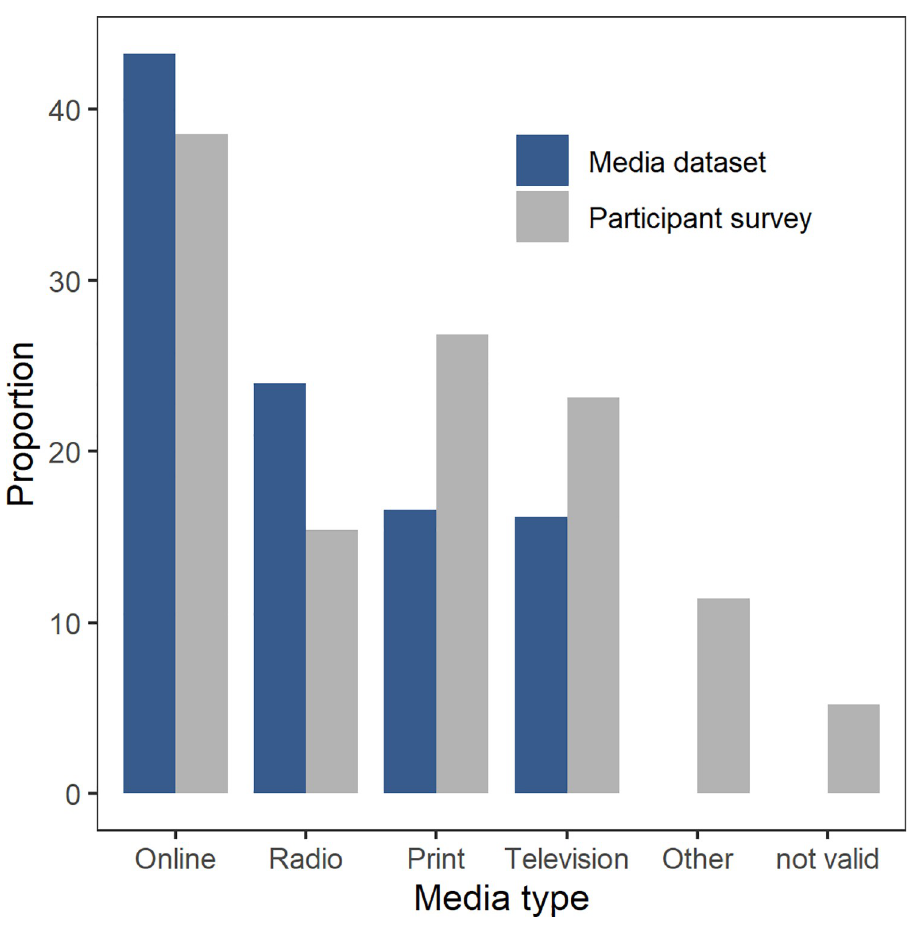
Fig 5. Comparison of the proportions of media types from the media clipping dataset and those from the participant responses. For the participant responses, the category ‘print’ also includes ‘magazines’; the ‘personal’ category was assigned to